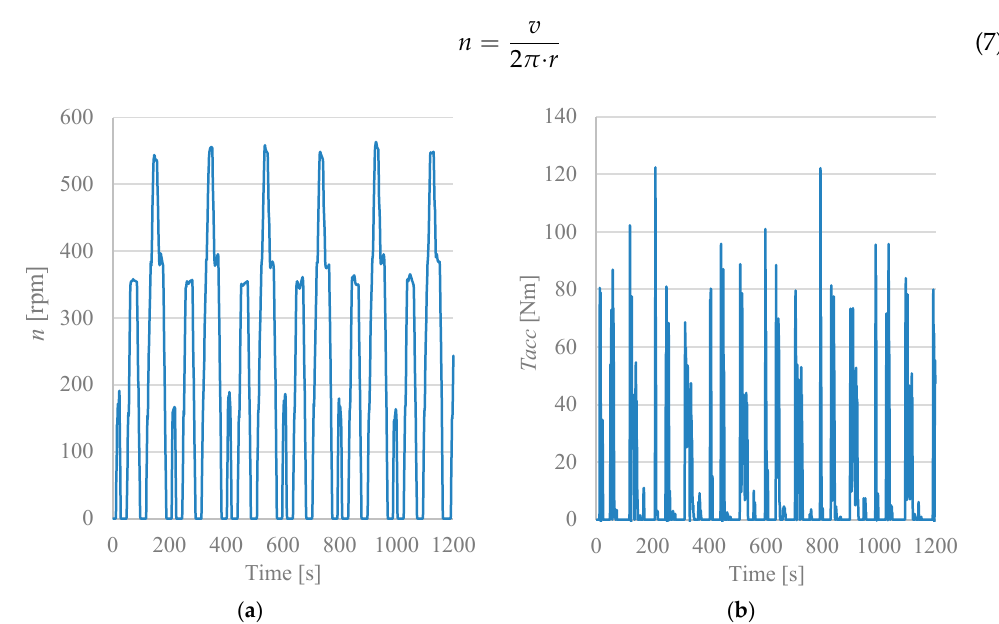
Figure 6. The angular speed n ( a ) and the acceleration torque T acc ( b ) during the UDC driving cycle.